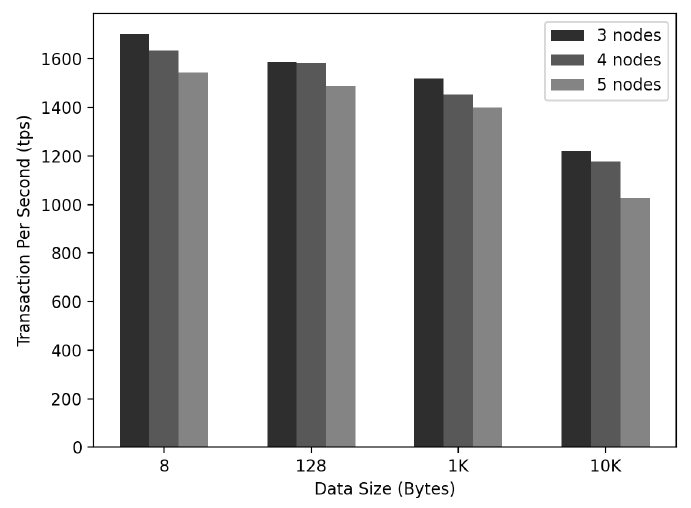
Figure 16. IoT-Chain TPS